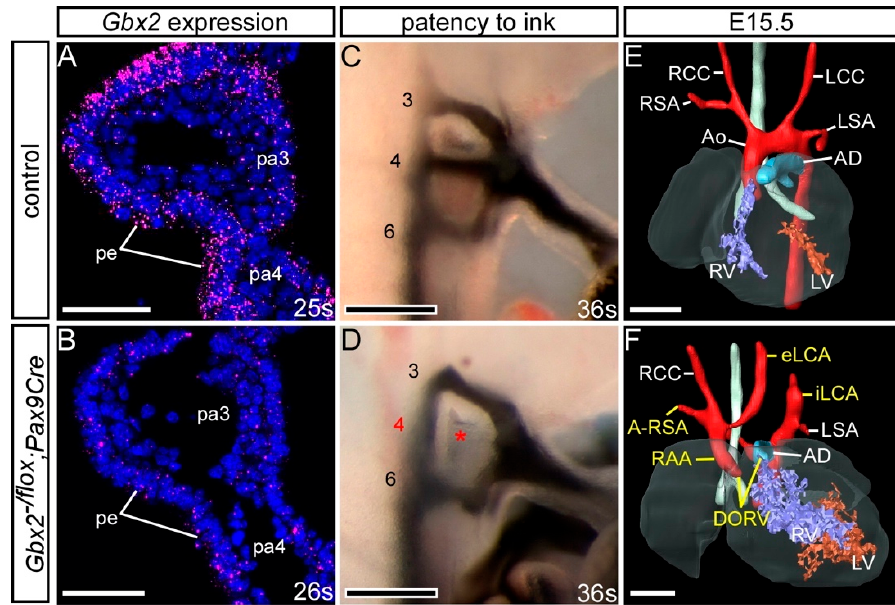
Figure 7. Conditional deletion of Gbx2 from the pharyngeal endoderm. Embryos with one Gbx2 -null allele and a heterozygous conditional deletion of Gbx2 using Pax9Cre ( Gbx2 − / flox ;Pax9Cre ) were analysed. ( A , B ) RNAscope in situ hybridisation for Gbx2 at E9.5 (n = 5 per genotype; 24–29 somites). ( A ) In control embryos Gbx2 expression was observed in the pharyngeal endoderm (pe) of the pharyngeal arches (pa). ( B ) Gbx2 expression was reduced in the pharyngeal endoderm of Gbx2 − / flox ;Pax9Cre mutants. ( C , D ) Embryos at E10.5 were analysed by intracardiac ink injection (36–38 somites). ( C ) Control embryos had normal PAAs patent to ink. ( D ) Gbx2 − / flox ;Pax9Cre embryos (n = 14) showed PAA defects such as absent 4th PAAs (asterisk). ( E , F ) 3D reconstructions of E15.5 hearts from MRI datasets. ( E ) Control embryo with normal heart and aortic arch arteries. ( F ) A Gbx2 − / flox ;Pax9Cre embryo (from n = 14 analysed) with double-outlet right ventricle (DORV), right-sided aortic arch (RAA), aberrant right subclavian artery (A-RSA) and abnormal left external and internal carotid arteries (eLCA, iLCA). Scale bars: 50 µ m in ( A , B ); 100 µ m in ( C , D ); 500 µ m in ( E , F ). Abbreviations: Ao, aorta; AD, arterial duct; LCC, left common carotid artery; LSA, left subclavian artery; LV, left ventricle; RCC, right common carotid artery; RSA, right subclavian artery; RV, right ventricle; s, somite. The somite numbers given in the legend reflect the range analysed for the whole study. The figure contains representative images only.